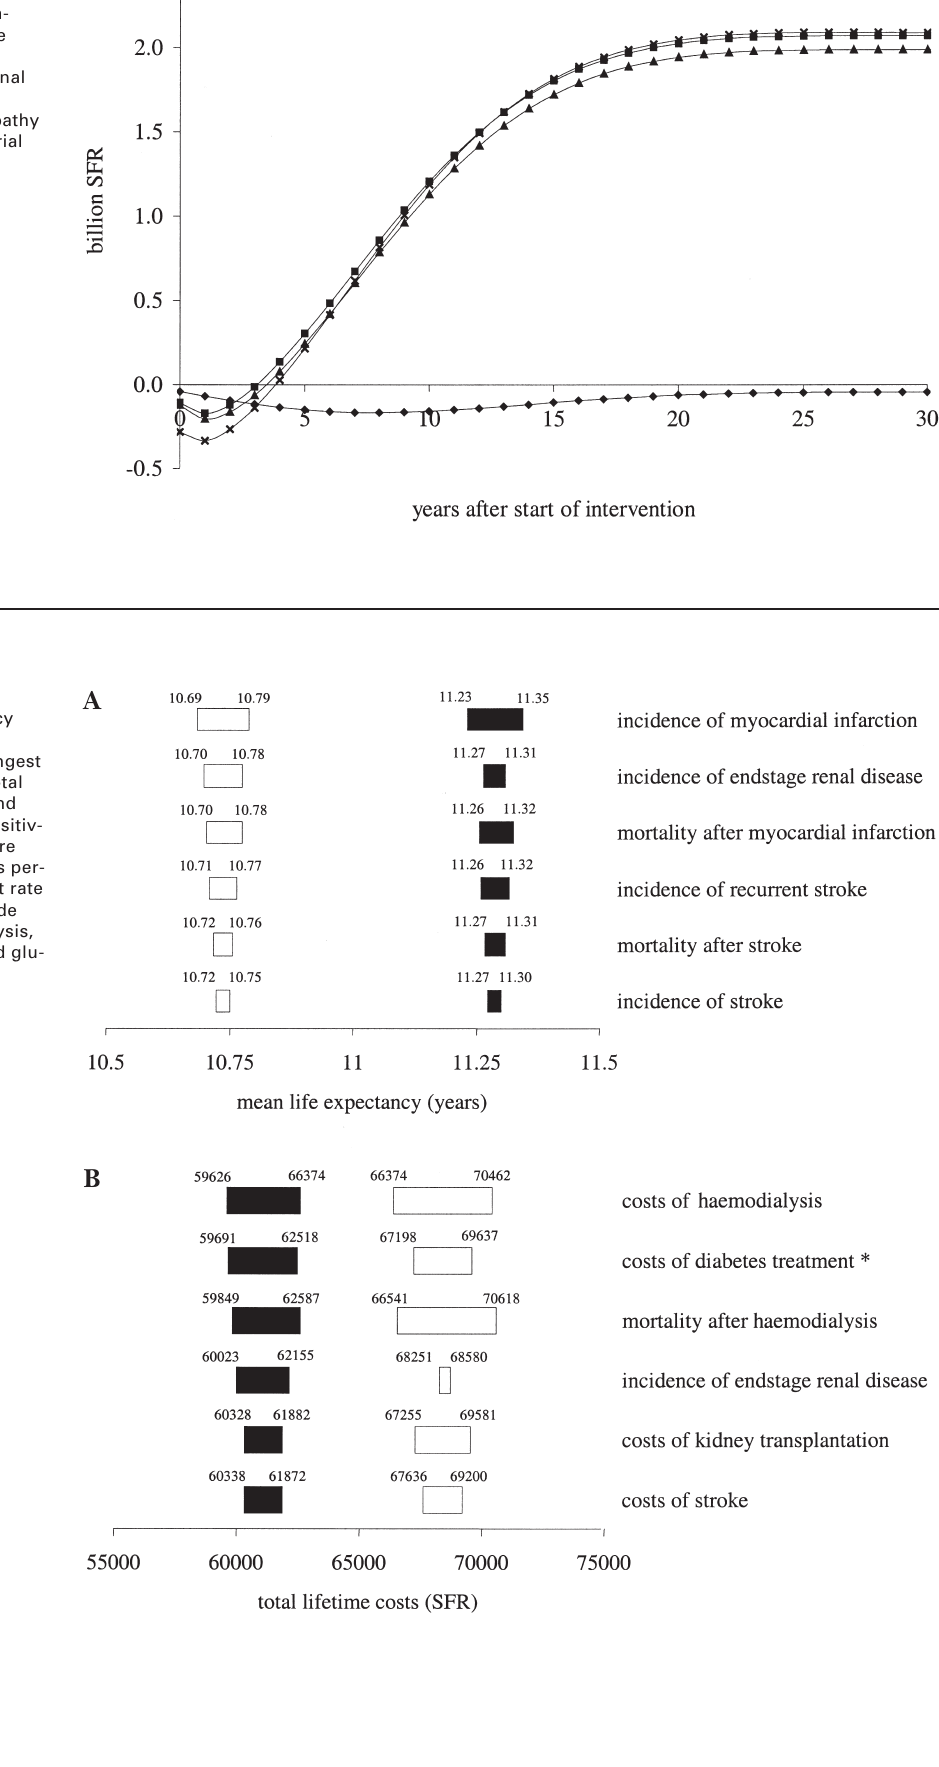
Cumulative discounted savings (discount rate 3%) of various intervention strategies com- pared to standard care, extrapolated to the Swiss type 2 diabetes population.